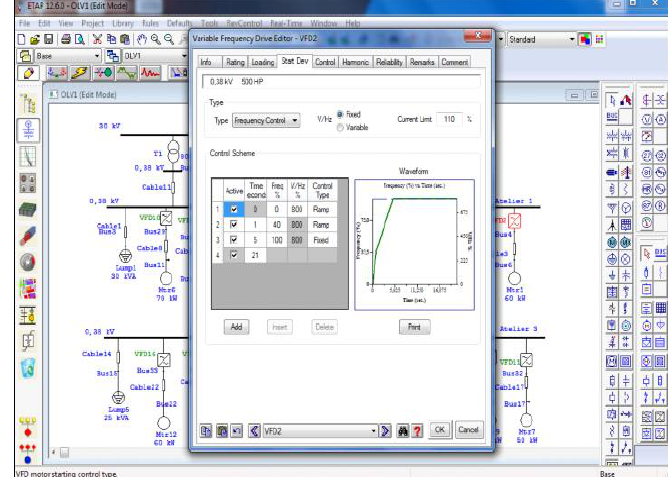
Figure 11: Setting the starting frequencies VFDs.